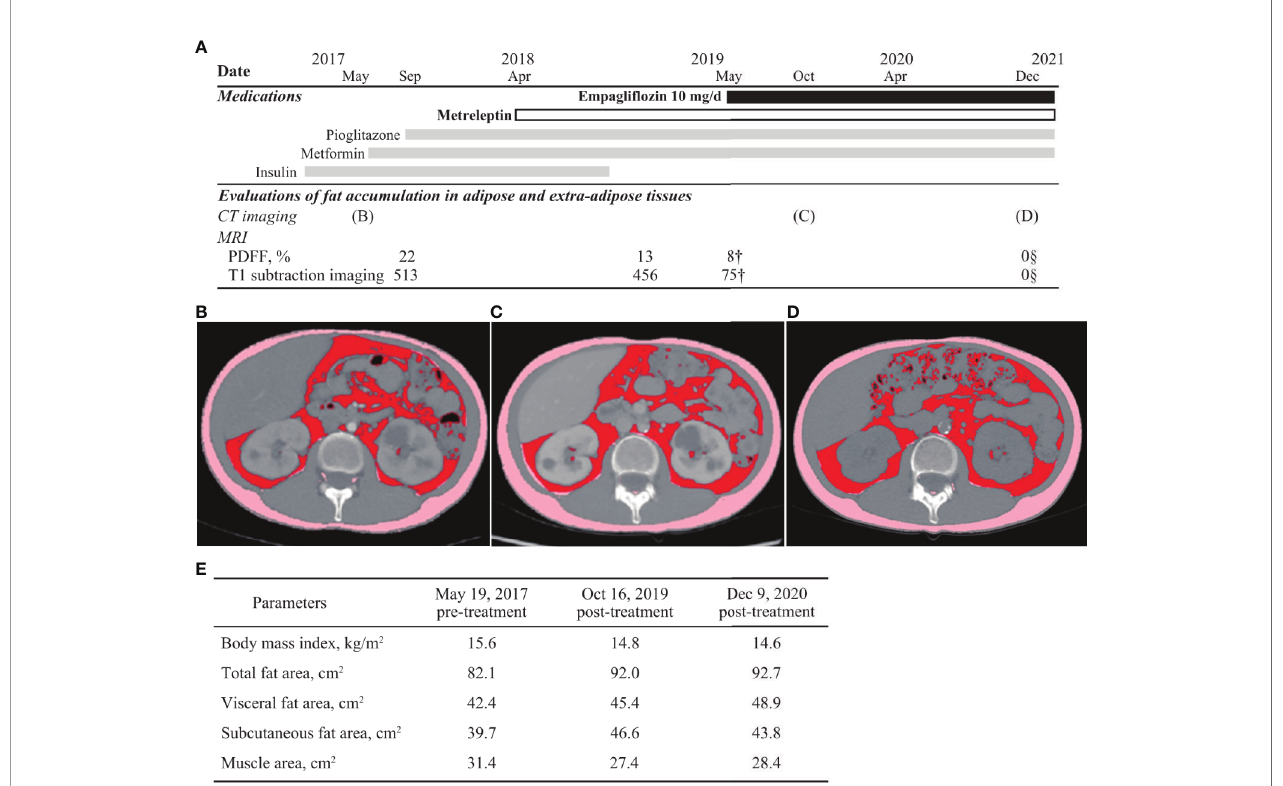
FIGURE 2 | Evaluations of fat accumulation in the adipose and extra-adipose tissues. Body fat accumulation has been evaluated during the clinical course. (A) The time of evaluation using computed tomography (CT) imaging and magnetic resonance imaging as well as clinical time course of medications are presented. Fat accumulation in liver is decreased and eventually, not detected using the proton density fat fraction (PDFF) method and T1 subtraction imaging. Areas of visceral, subcutaneous, and total fat are increased, observed in the CT imaging analysis between before (B) and after (C, D) metreleptin and empagli fl ozin administrations, although muscle areas are not increased (E) . Additionally, changes in fat volume and body mass index between before- and after-combination therapy using SGLT2 inhibitor and metreleptin administration are demonstrated. CT, computed tomography; PDFF, proton density fat